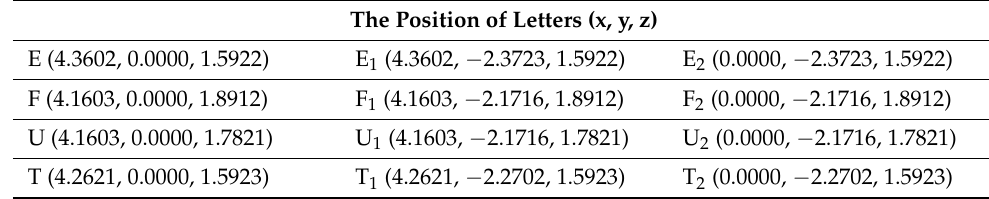
Figure 4. The letters corresponding to the air supply outlets. Table 4. The corresponding coordinates of each letter in the air supply